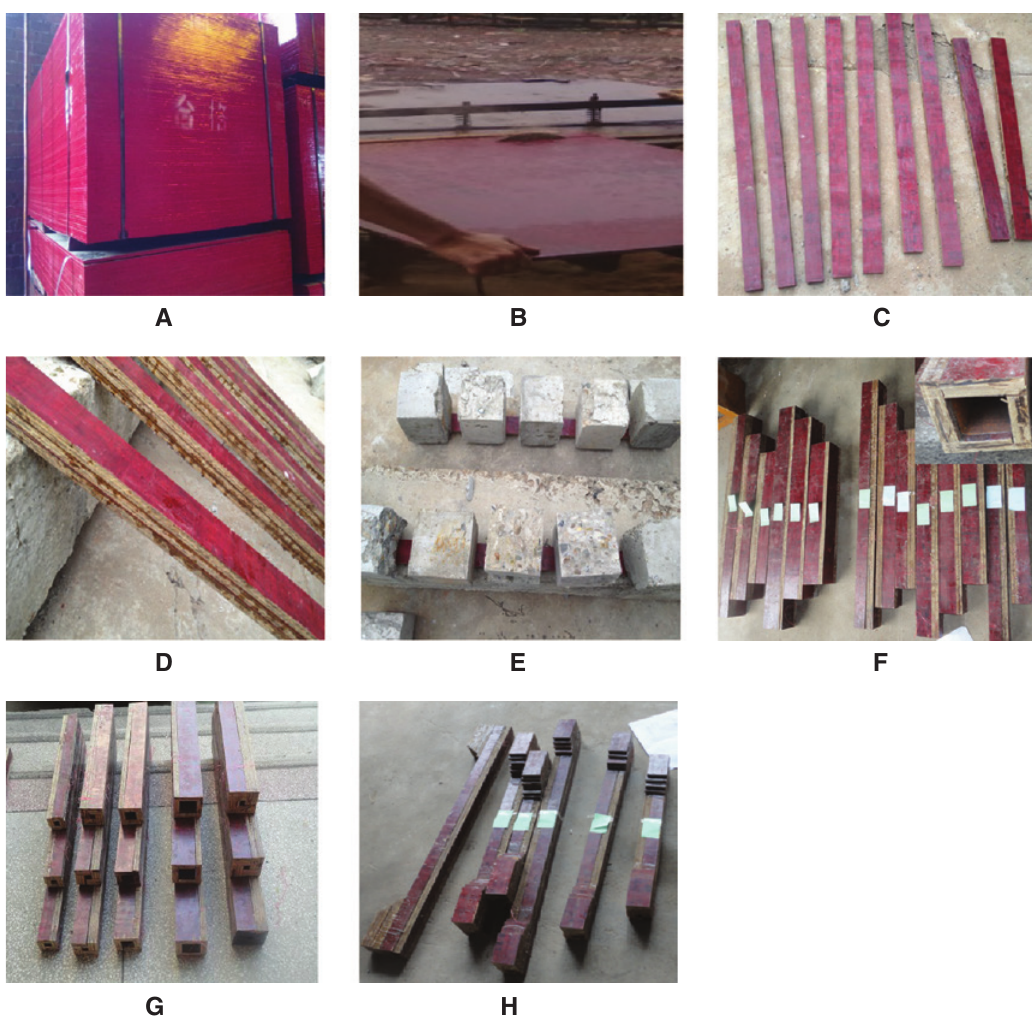
Figure 7: Primary production processes for